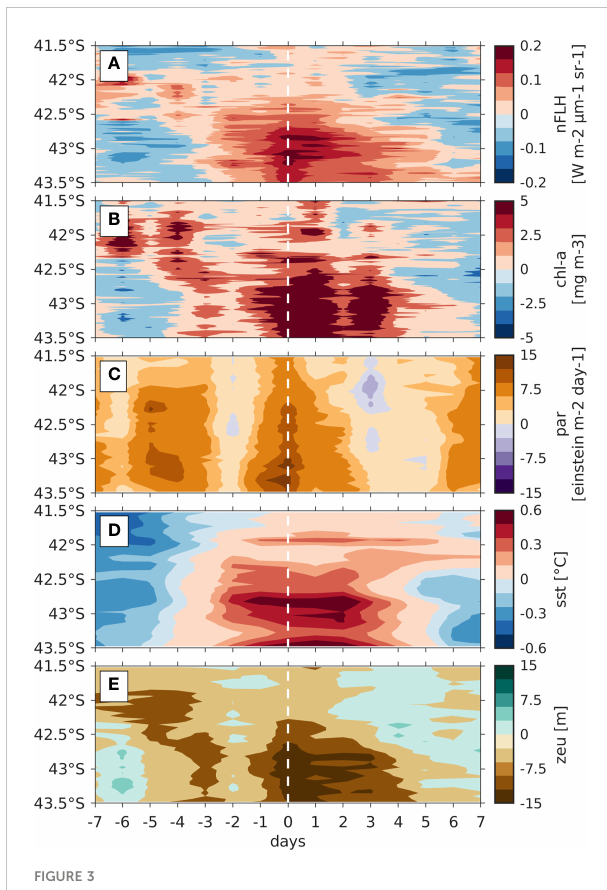
FIGURE 3 Hovmöller diagrams averaged from the 16 HBE over the longitude band 72.5°-74°W, and centred on the HBE onset, i.e., on day 0, spanning from day -7 to day +7. The variables correspond to (A) nFLH ’